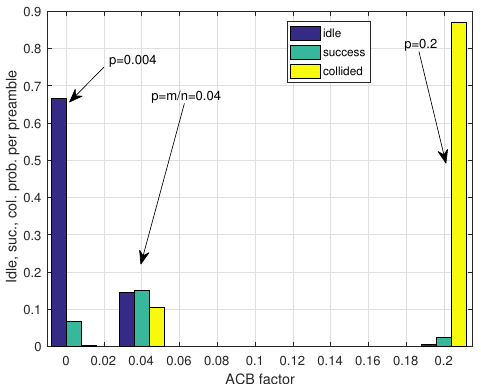
Figure 3. Importance of choosing optimal access class barring (ACB) factor: No. of devices, U = 1000, No. of preambles, R = 40, simulation time = 10 6 slots for fixed probabilities, p = 0.004,0.2, and 0.04